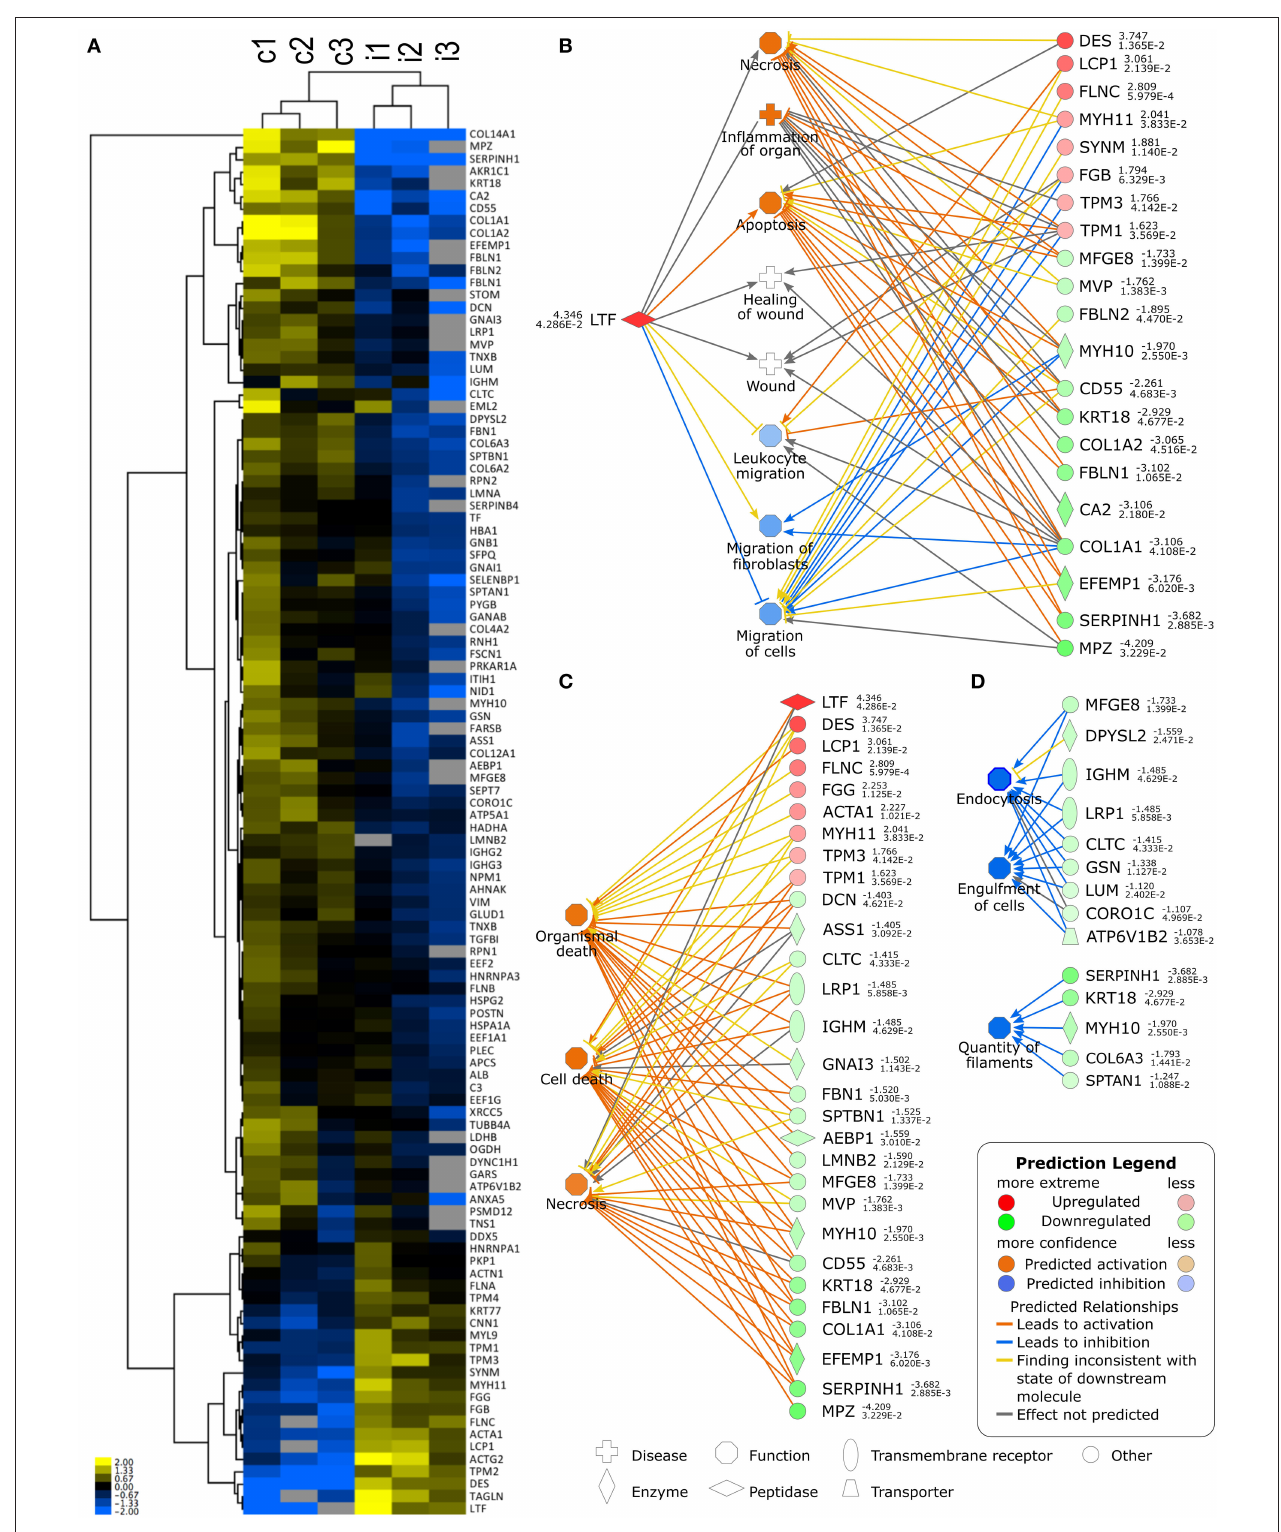
FIGURE 3 | (A) Heatmap clustering of differentially expressed proteins in three consecutive tissue sections of 3 month follow-up control (c1-3) and injured (i1-3) biopsy samples. (B) Lactoferrin (LTF)-associated activated and inhibited pathways and identified differentially expressed proteins (DEPs) associated to each. (C) Top 3 predicted upregulated pathways and their associated DEPs. (D) Top 3 predicted inhibited pathways and their associated DEPs. Differentially expressed proteins and associated signalling pathways were analysed using Ingenuity Pathway Analysis (IPA).